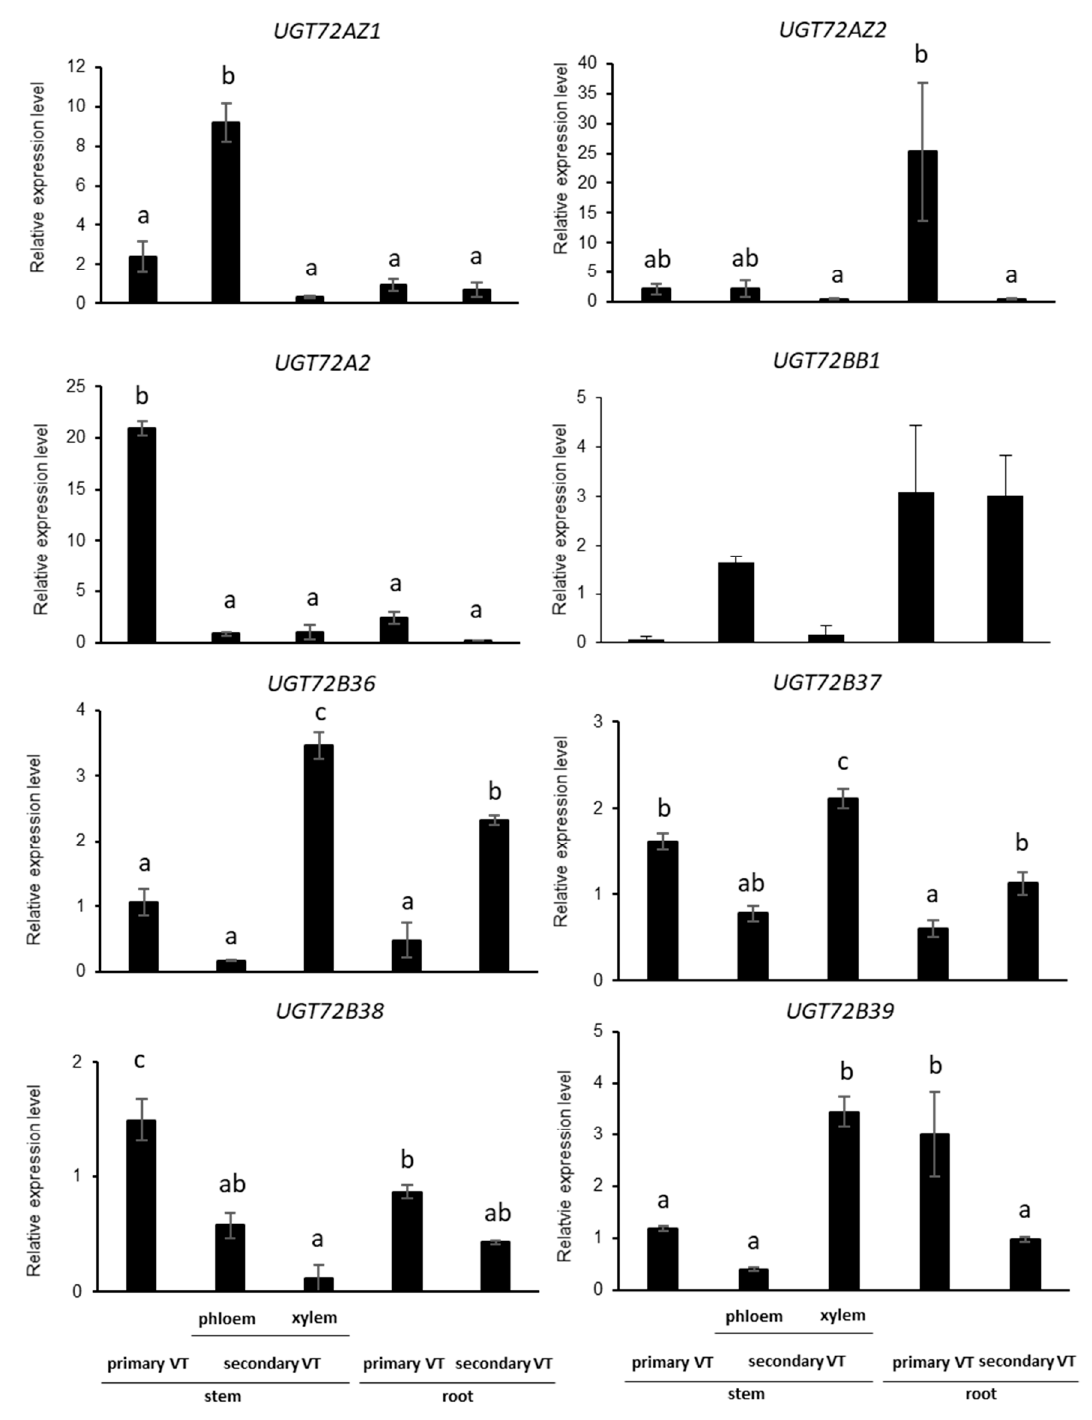
Figure 5. RT-qPCR expression profile of UGT72s in di ff erent parts of 4-month-old poplar trees grown in the greenhouse. Normalized relative expressions are means of 3 biological replicates ( ± SE). Significantly di ff erent values ( p < 0.05) are represented by di ff erent letters (ANOVA and Tukey post hoc test). VT, vascular tissue.